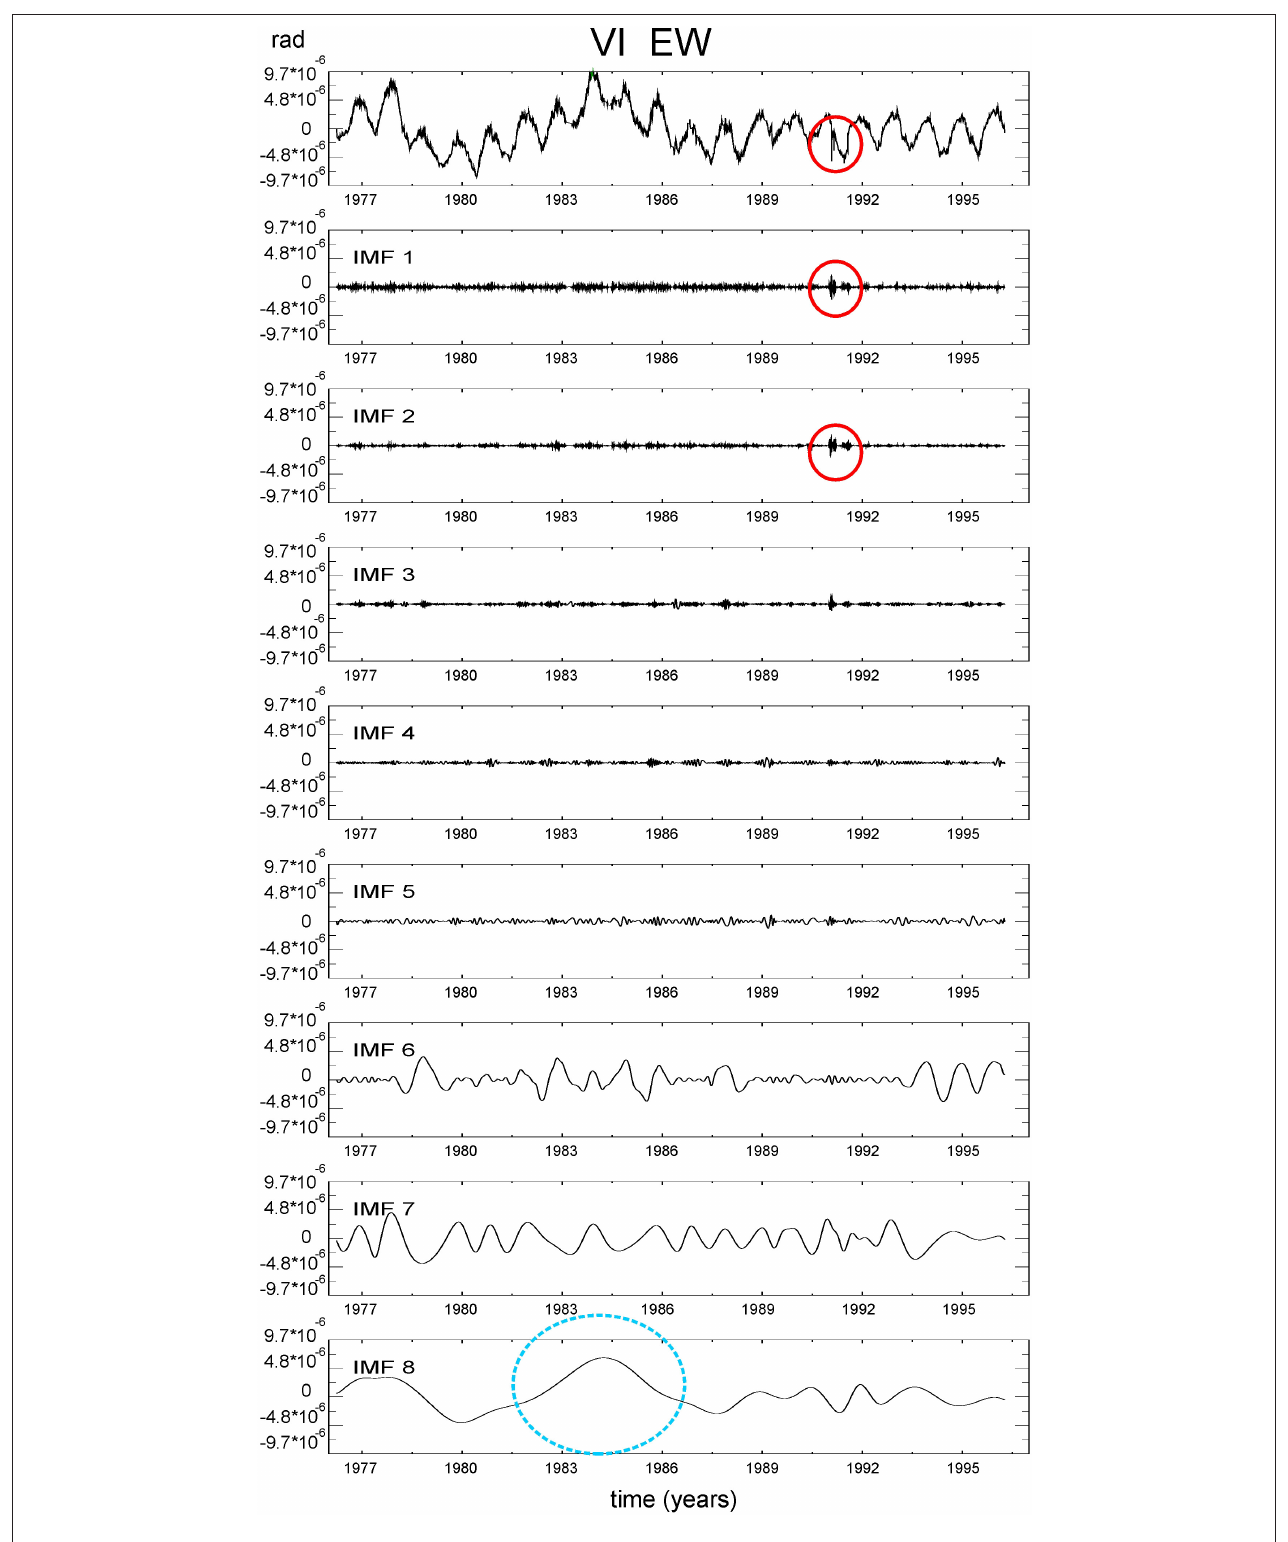
FIGURE 6 | The resulting mode decomposition components from the signal VI (EW): from top to bottom, the original signal, subtracted the long-term trend (the residual of EMD), and the IMFs resulting from EMD: the wavelength of the oscillations increases with the IMF number. IMF1 and IMF2 contain rainfall-induced and co-seismic signals (red ellipse also in the original data). IMF 8 contains the transient of study (fair blue ellipse). Positive: toward East.